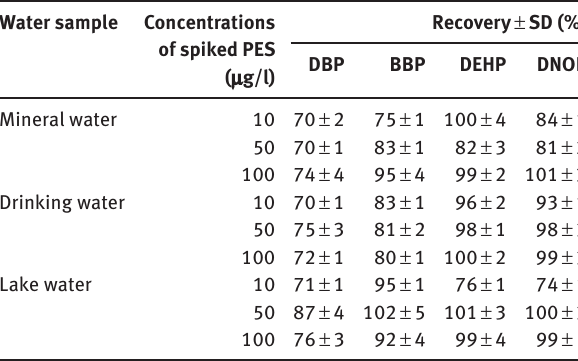
Table 3: Recoveries of PES in the real water